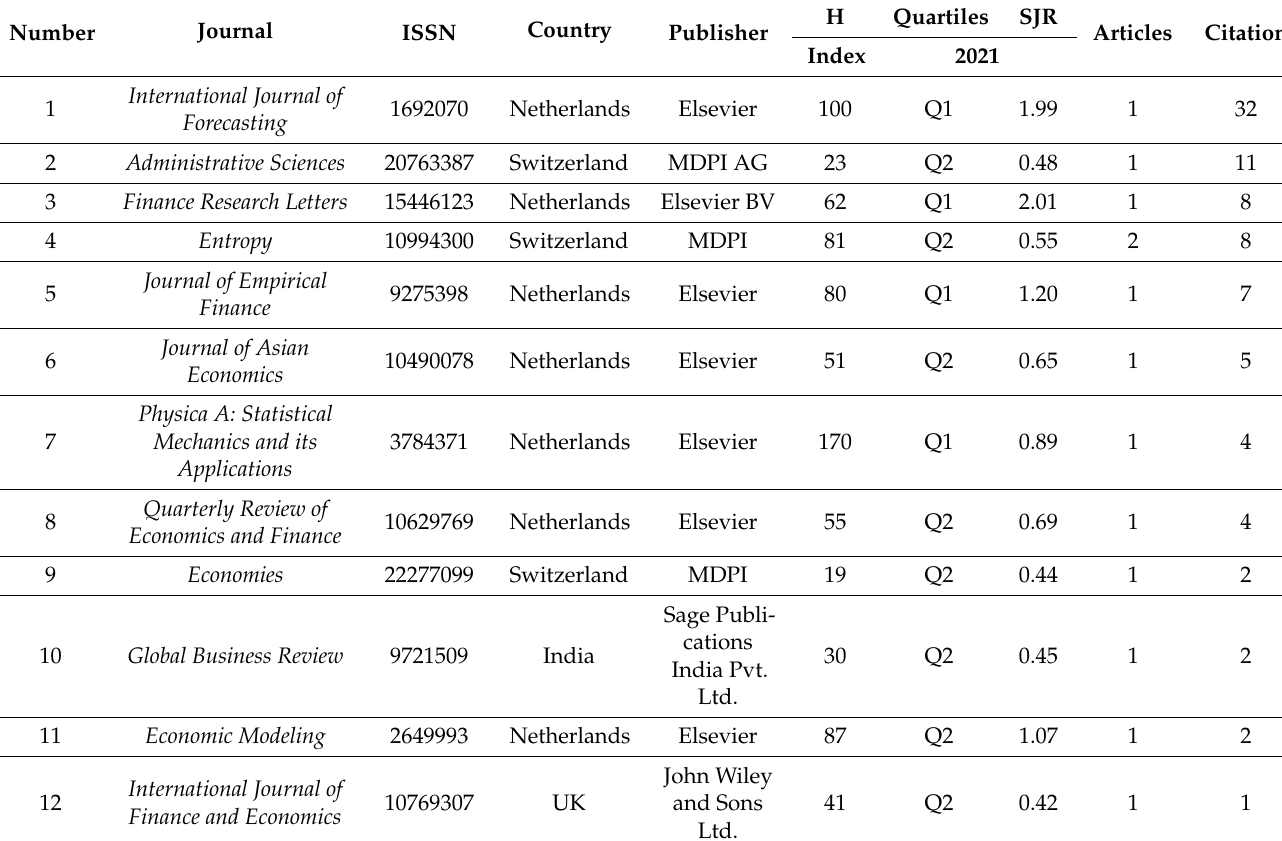
Table 7. Journals by the number of